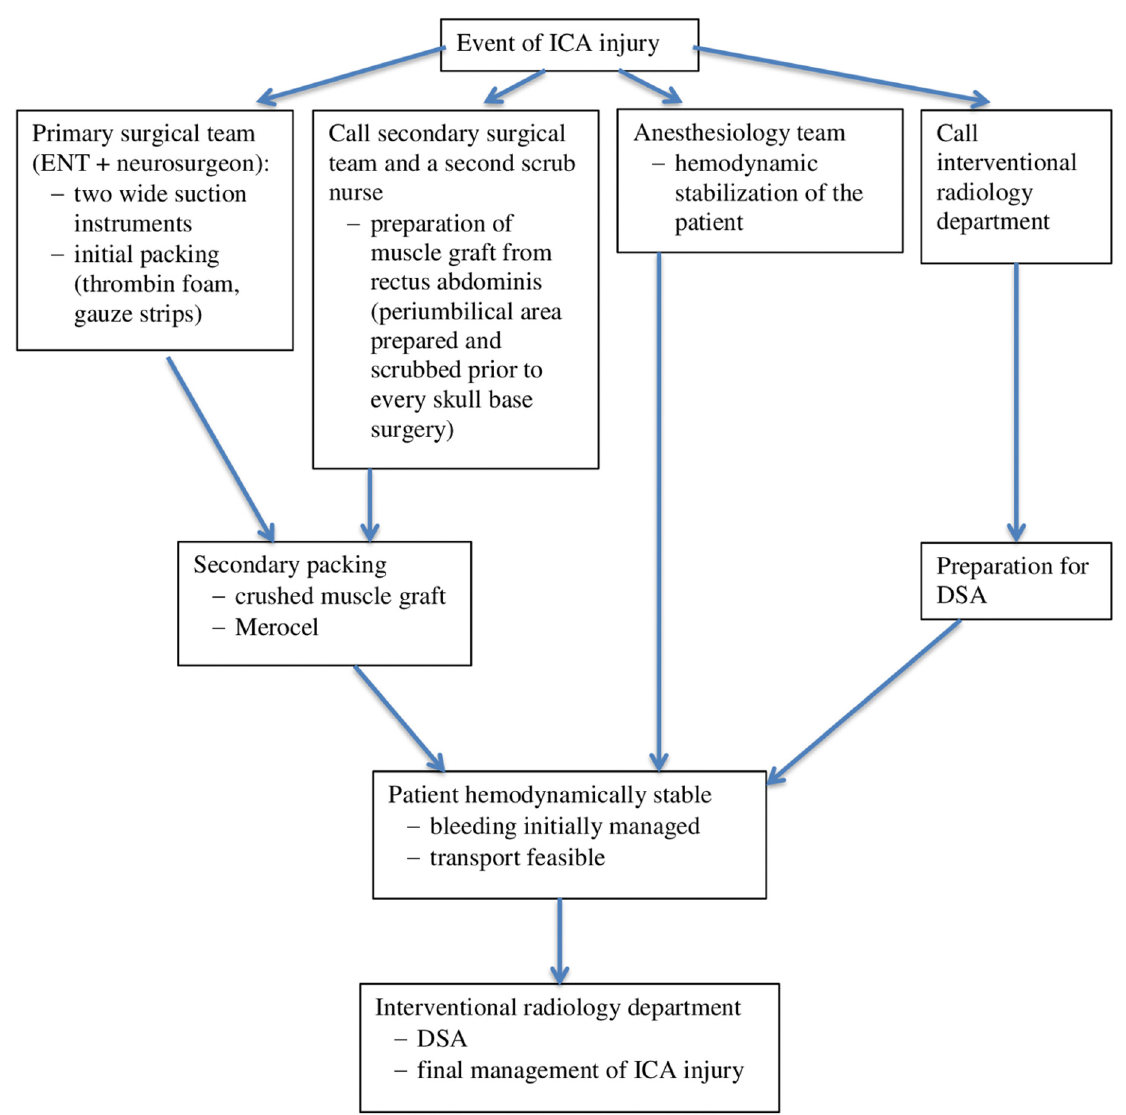
Figure 2. Algorithm for managing an internal carotid artery (ICA) injury, developed at the University Hospital Ostrava. ENT: ear, nose, throat; Merocel: polyvinyl acetate packing strips; DSA: digital subtraction angiography.